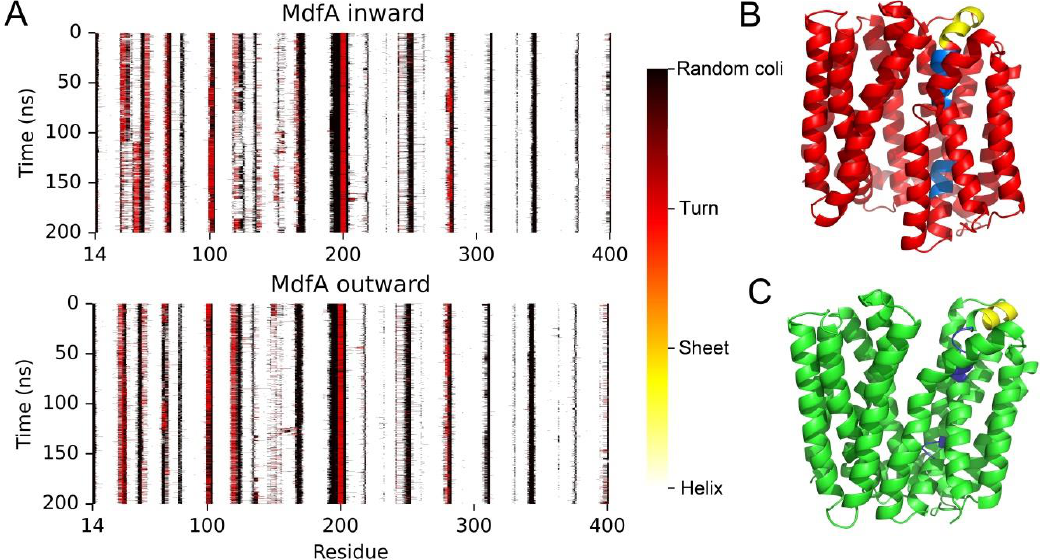
Figure 7. MdfA inward had altered secondary structure of helix 1. ( A ): Heatmap of the secondary structures of MdfA inward and MdfA outward throughout the two simulations. ( B ): Loops in helix 1 were changed into helix (Blue) for MdfA inward1325 , and the top of helix 1 (Yellow) became upright compared to the structures in MdfA outward ( C ).